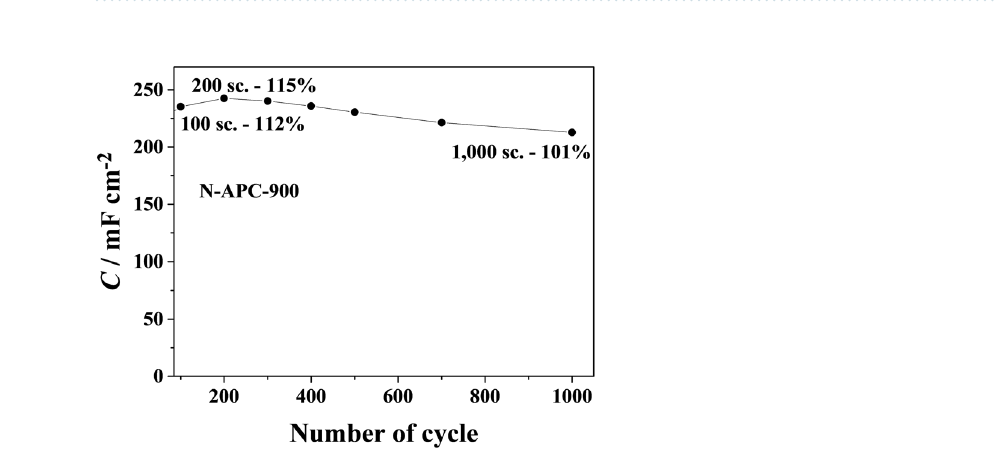
Figure 5. Curves of specific capacitance plotted as a function of cycle number for N-APC-900 (1000